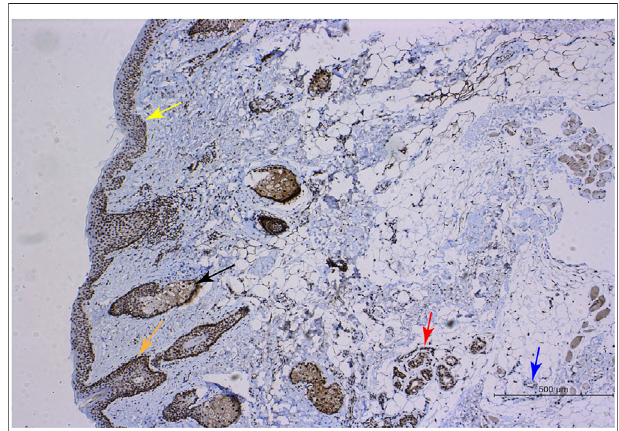
FIGURE 1 | RGR expression in human skin tissue. Immunohistochemical methods were used to show positive RGR staining in the epithelial layer (yellow arrow), sebaceous gland (black arrow), hair follicle (orangearrow),sweat gland(red arrow),and blood vessel (bluearrow)of skin tissue. Scale bar = 500 μ